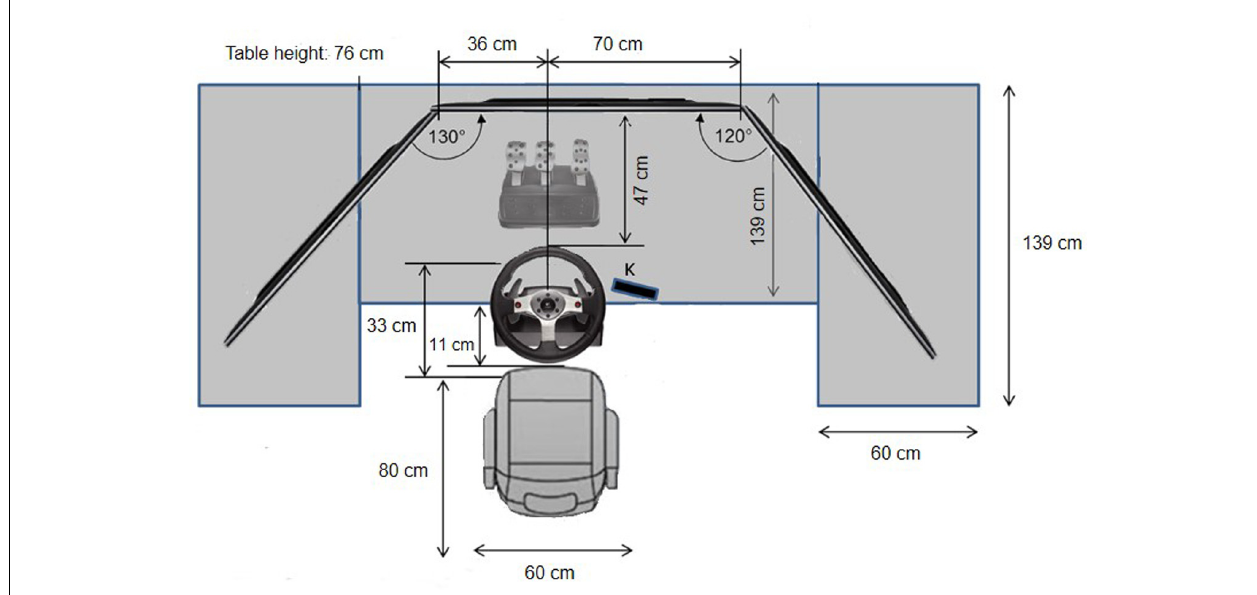
FIGURE 1 | Driving setup, Top view. Keypad marked with ‘K,’ three monitors (black color in the picture) lined up as shown on top of three tables (gray color in the picture). Central table made transparent in the picture to show pedals. Seat, steering wheel and pedals lined up as shown.